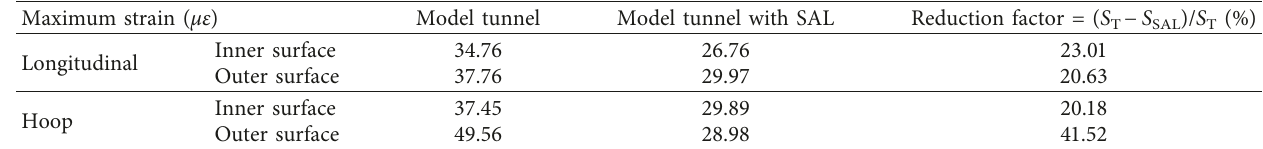
S SAL is the strain of the model tunnel with SAL and S T is the strain of the model